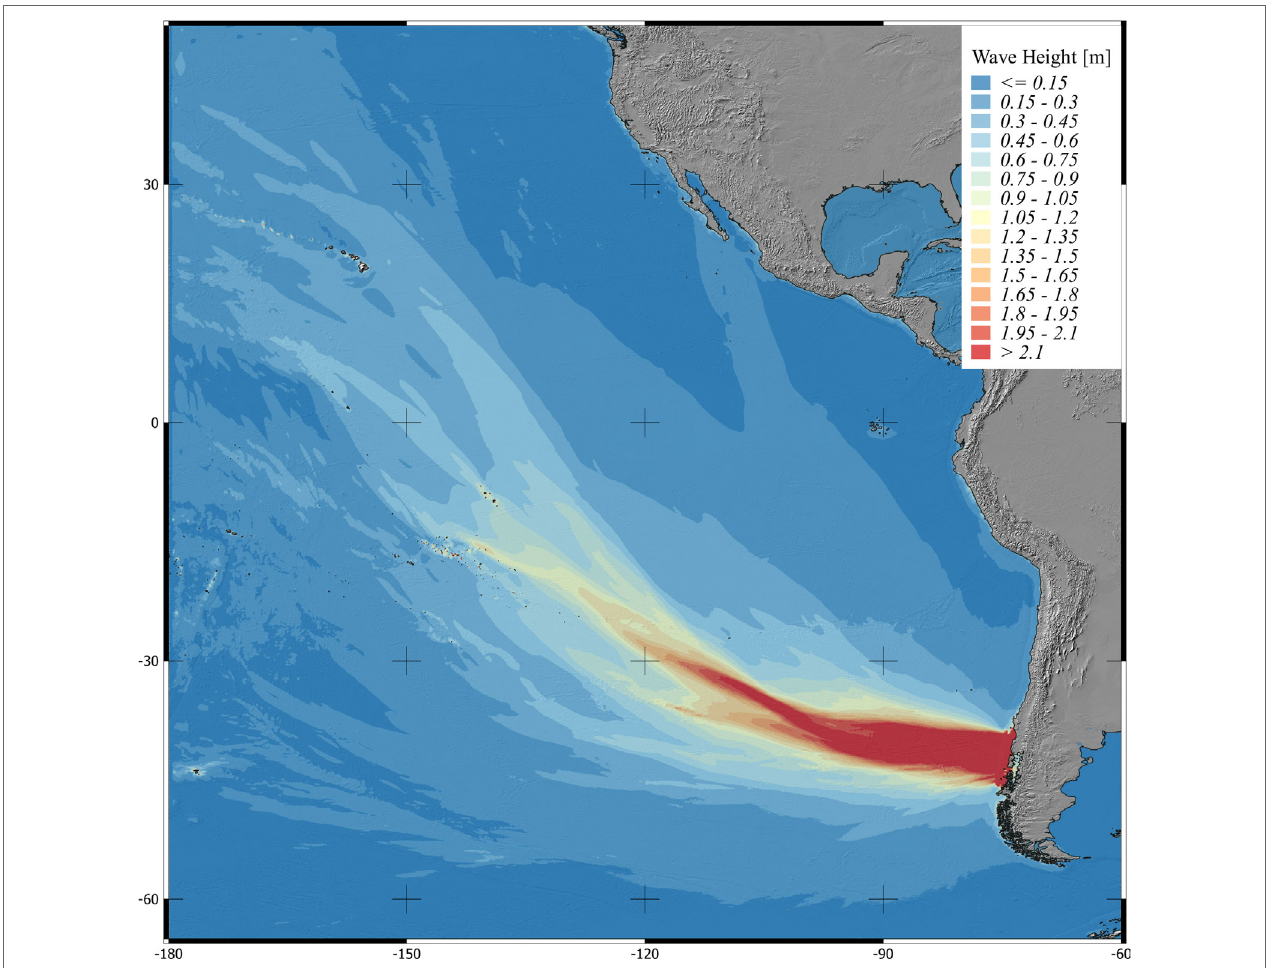
FigUre 10 | The modeling of the reanalyzed 1960 tsunami event and the effects on chile as well as hawaii